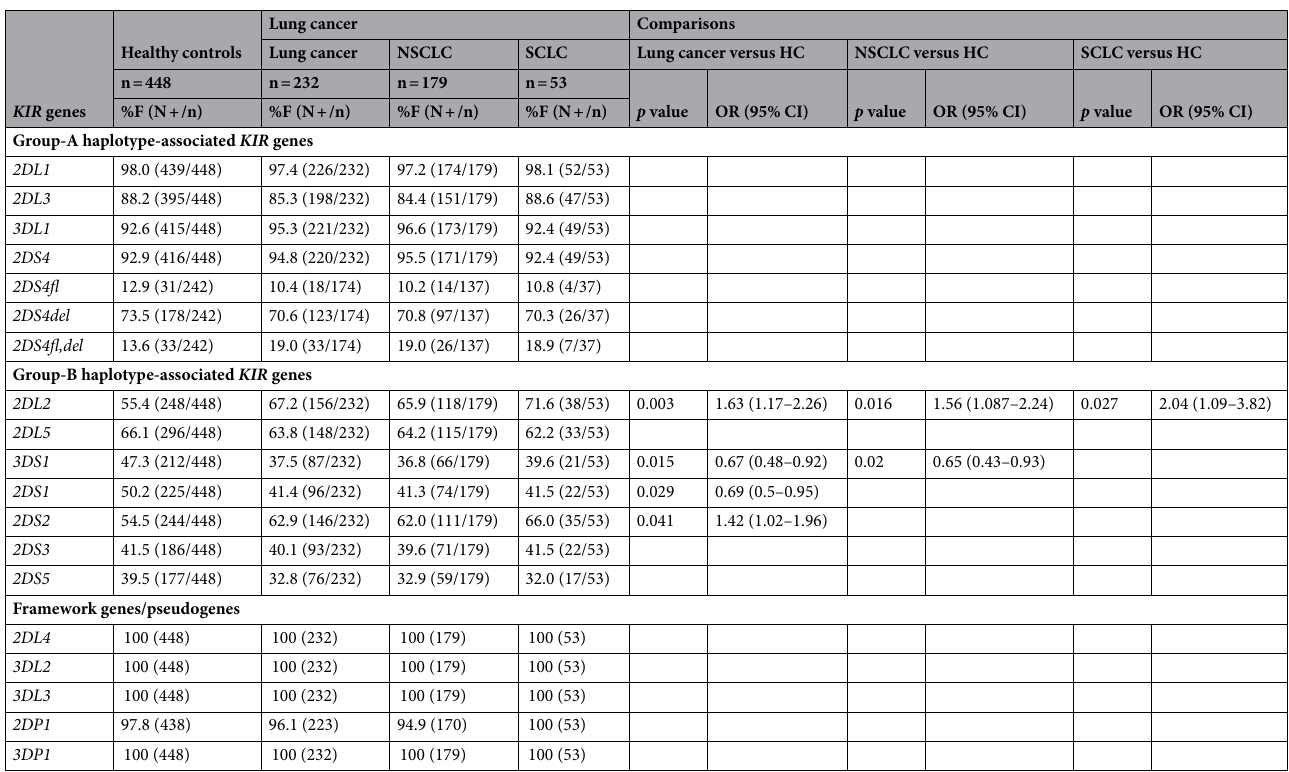
Table 2. KIR gene frequencies among patients with lung cancer and healthy controls. N + number of individuals positive for the gene, n number of individuals tested for the gene, HC healthy control, OR odds ratio, CI confidence interval. p < 0.05: statistically significant; based on two-tailed Fisher’s exact